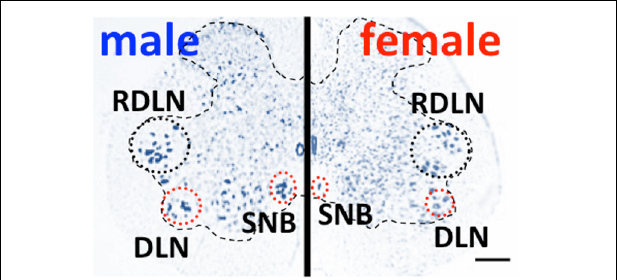
FIGURE 3 | Spinal nucleus of the bulbocavernosus (SNB) motoneurons are more numerous in male than in female rats. The dorsolateral